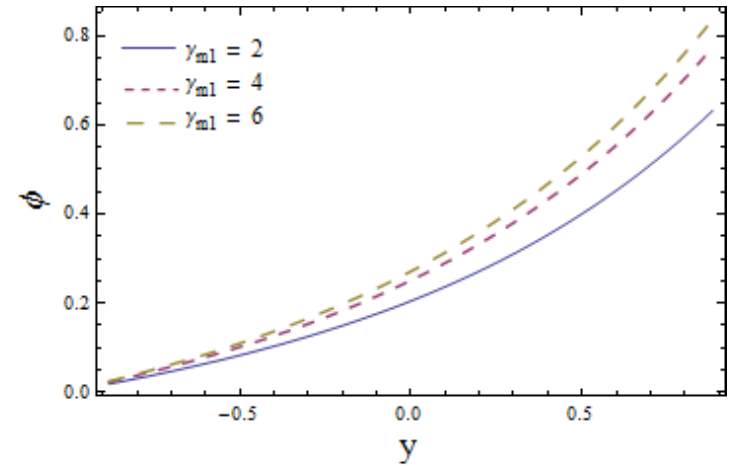
Figure 15. Mass concentration φ versus y for γ m 1 when (cid:101) = 0.2, τ ∗ = 2, x = 0.1, t = 0.1, γ h 1 = 6, γ h 2 = 8, γ m 2 = 8, γ = 1 and Sc =